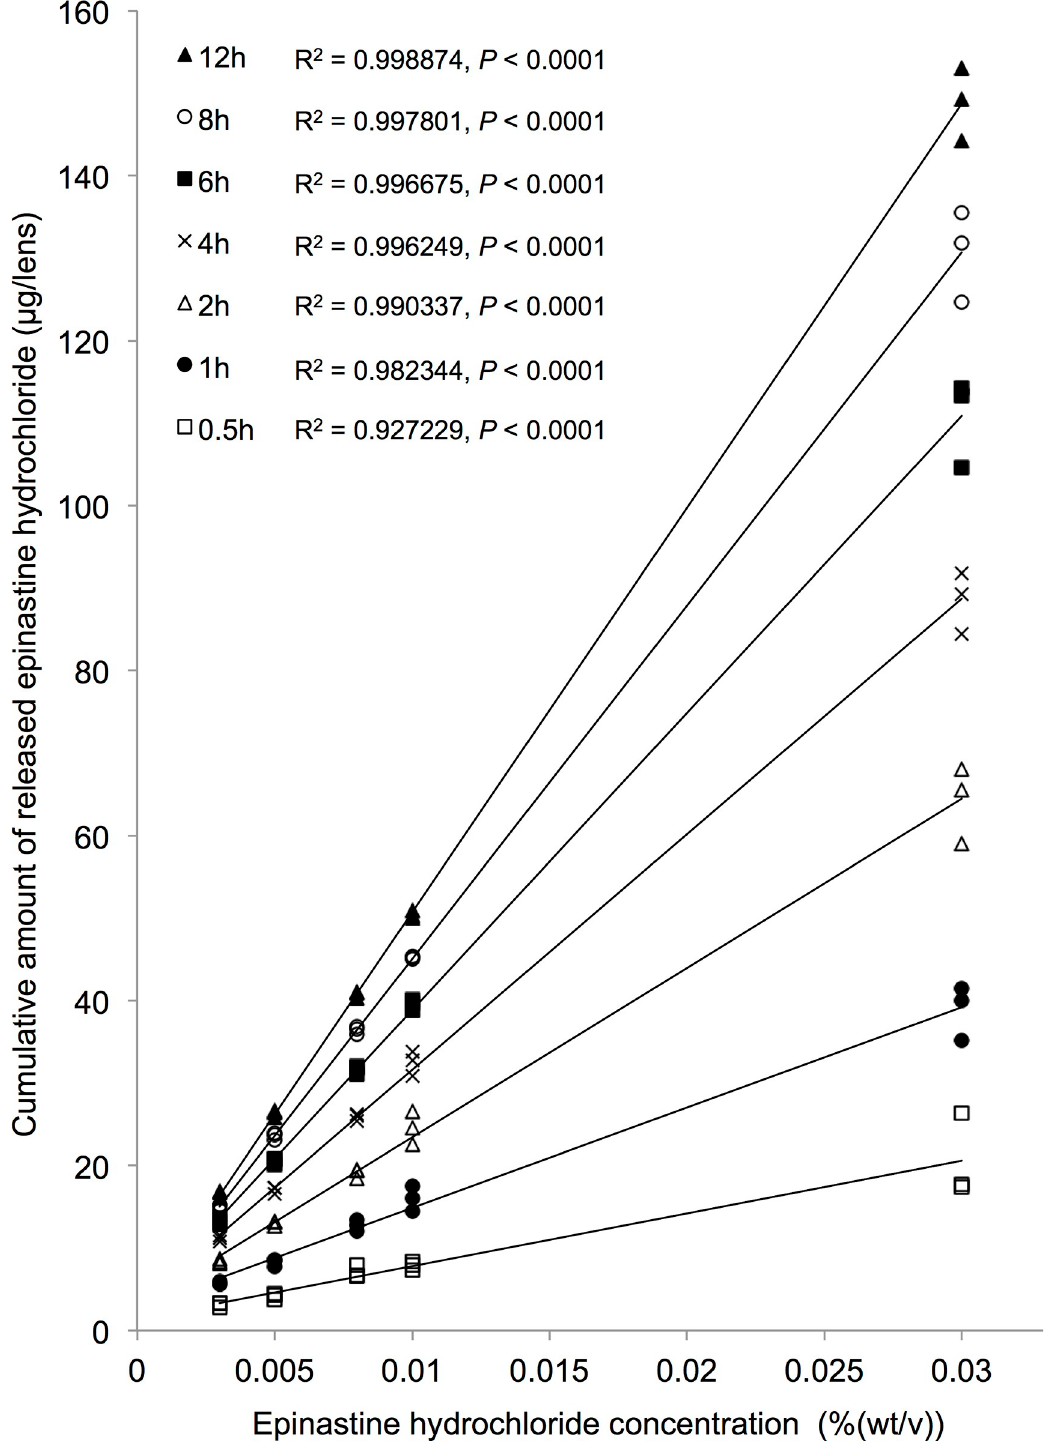
Fig 6. Correlations between epinastine hydrochloride (EH) concentrations and the release amounts. The EH-releasing soft contact lenses (EH-SCLs) demonstrated EH release directly proportional to the concentration of EH solutions used to make the